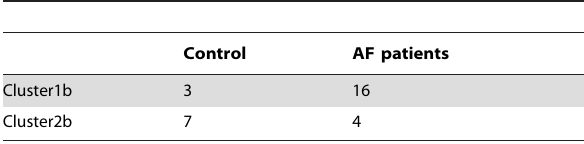
Table 2. Optimal cluster solution generated by OPC analysis on the U133B data set.